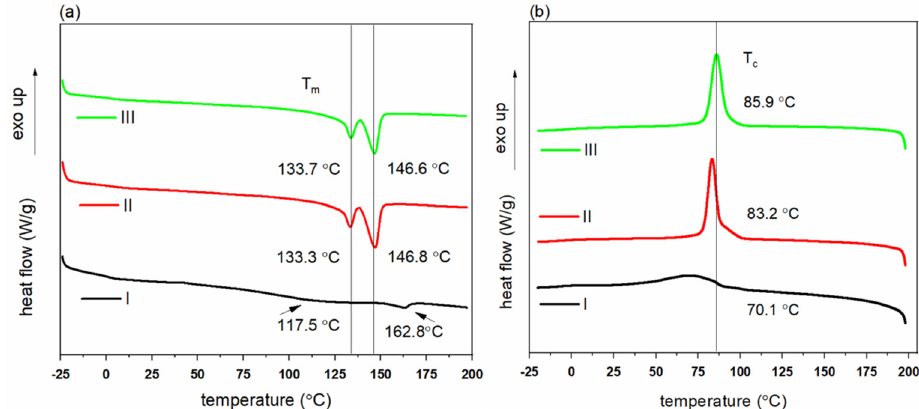
Figure 2. DSC curves of PHBH polymers grades: ( a ) melting curves (second heating), ( b ) cooling curves (first cooling). Curves have been offset vertically for better visibility.